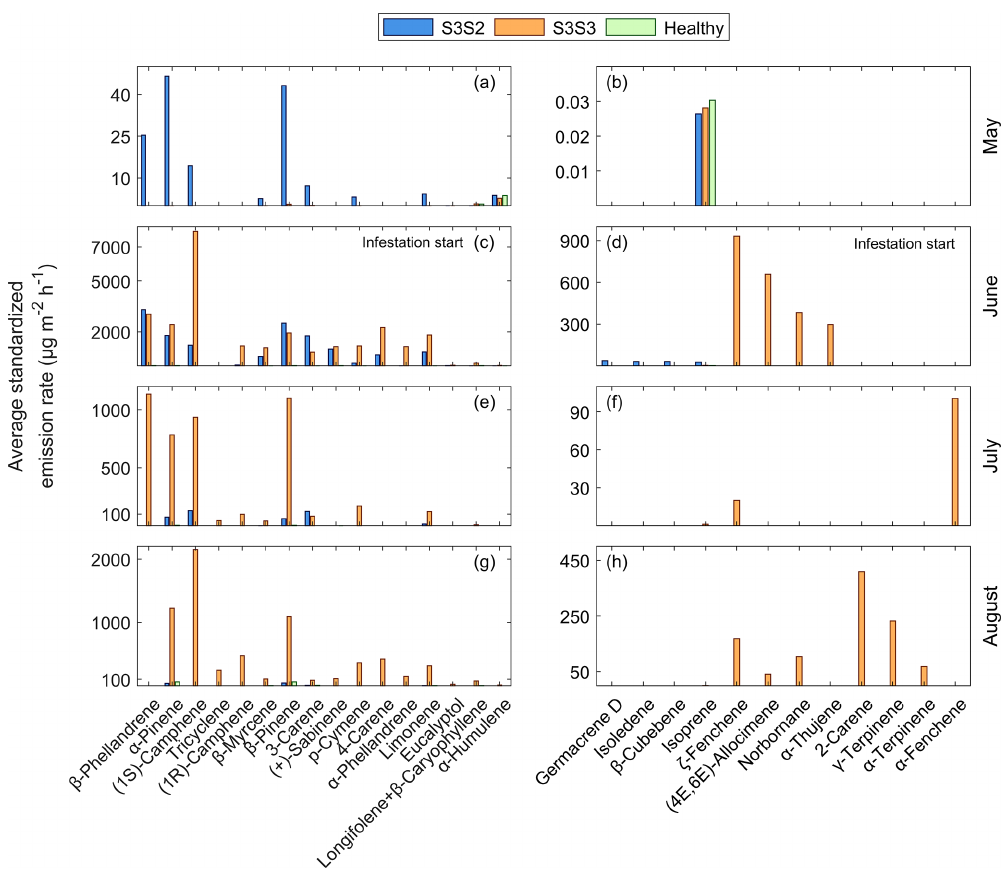
Figure 10. The daily average temperature standardized BVOC emission rates for all compounds from Norway spruce at plot 3 in Hyltemossa: infested spruce with ID S3S2 (blue), infested spruce with ID S3S3 (orange) and healthy trees (green). Measurements were taken in 2019 during (a, b) May, (c, d) June, (e, f) July and (g, h) August. The graphs are horizontally separated for visibility due to large differences in scale. The healthy trees are included in all graphs, but the emission rates are not visible on the same scale as the infested trees in (c, d) June or (e, f) July. The bark beetle infestation had not started in (a, b) May; however, the spruce S3S2 was already subjected to stress from late bark beetle attacks during the previous season before the bark beetle infestation started again in (c, d) June, leading to higher emission rates already in